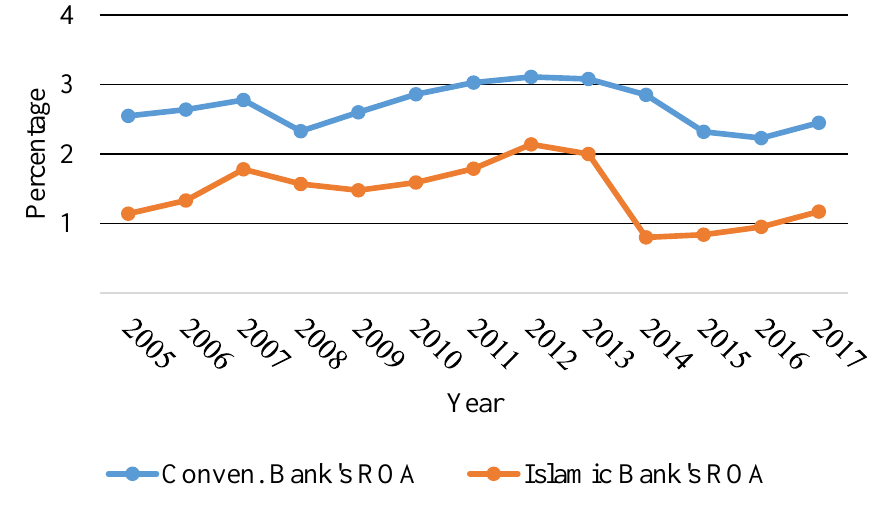
Fig. 1: Movement of conventional and Islamic ROA from 2005 -